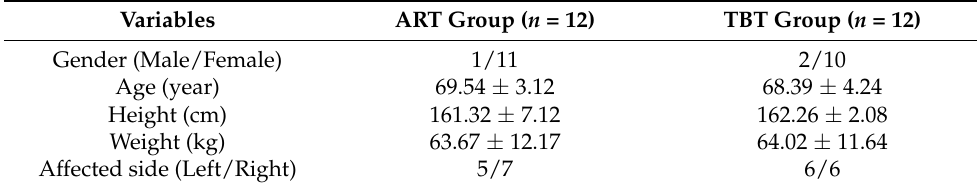
Table 1. Participant demographic